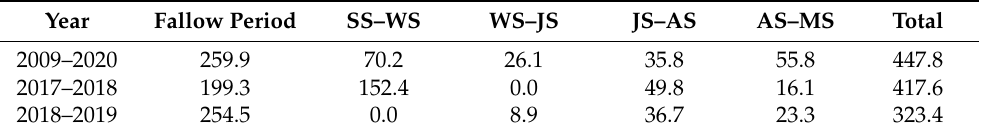
Table 1. Precipitation at the experimental site (mm).